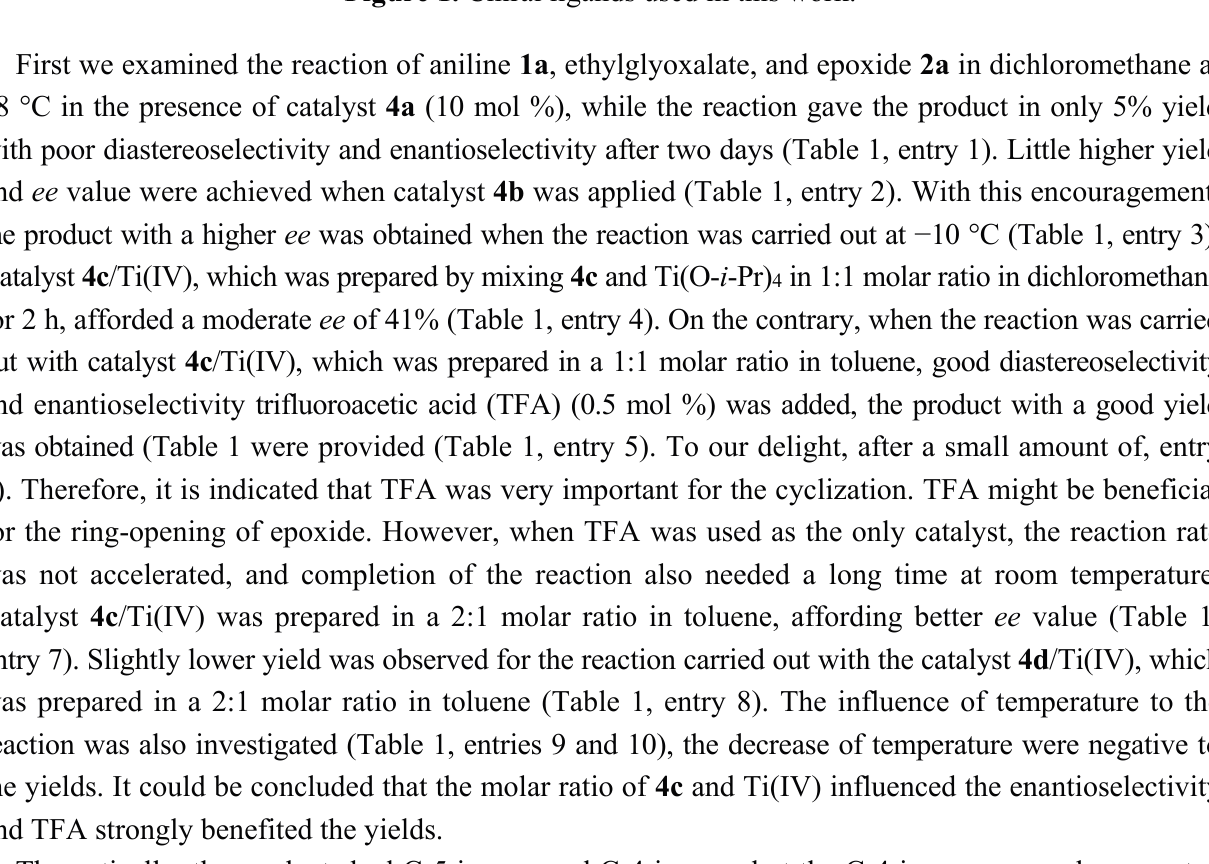
Figure 1. Chiral ligands used in this work.